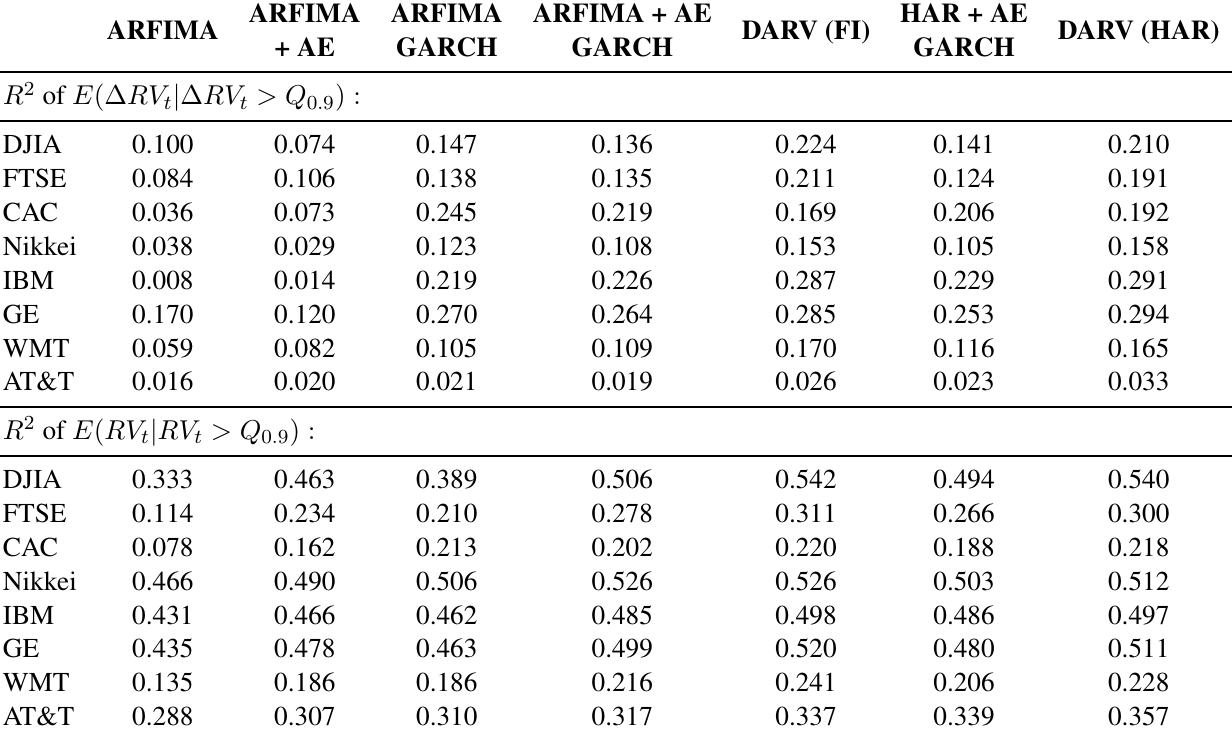
Table 11. Conditional forecasting results: other